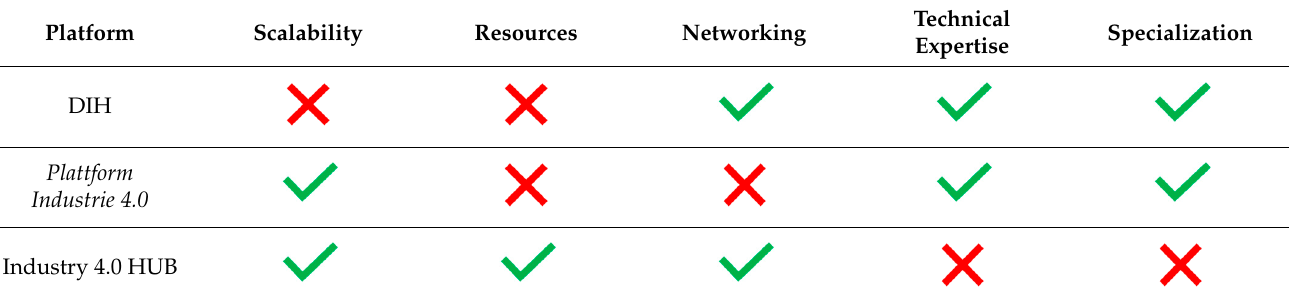
Table 2. Comparison between Industry 4.0 HUB, DIH, and Plattform Industrie 4.0.